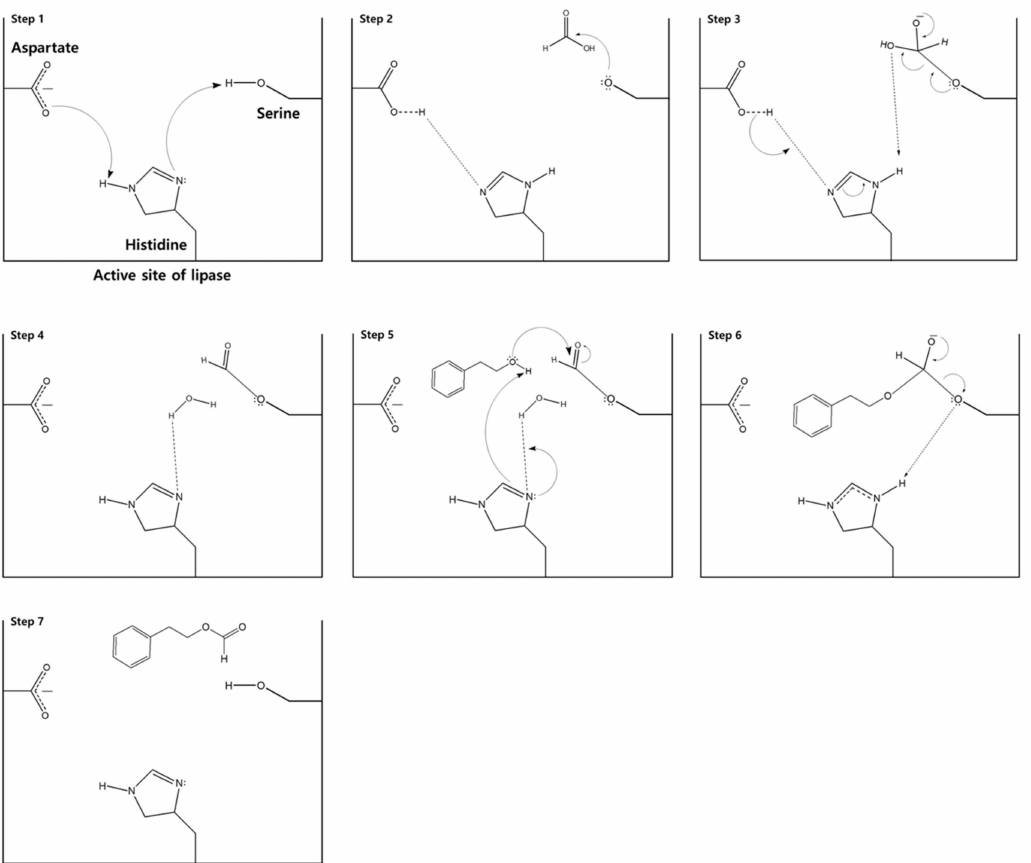
Figure 4. Mechanism for the lipase-catalyzed synthesis of phenethyl